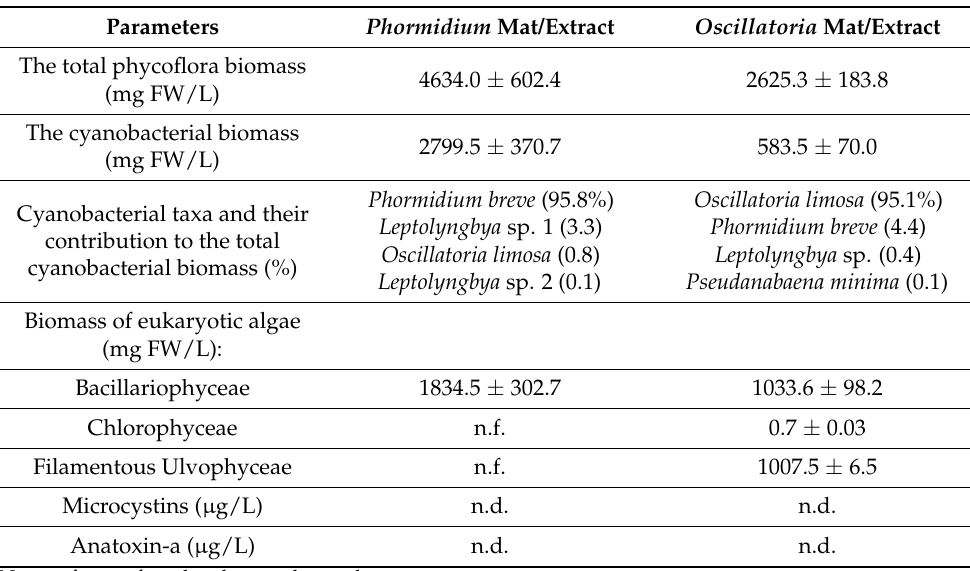
Table 1. Characteristics of microbial mats used to prepare crude extracts for bioassays. Data are expressed as means ± SD ( n = 4).